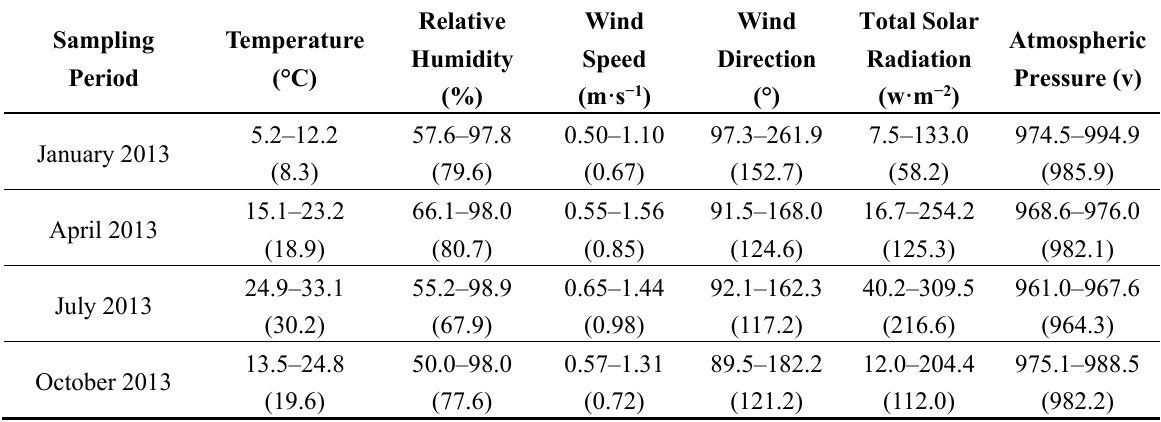
Table 1. Meteorological parameters during sampling